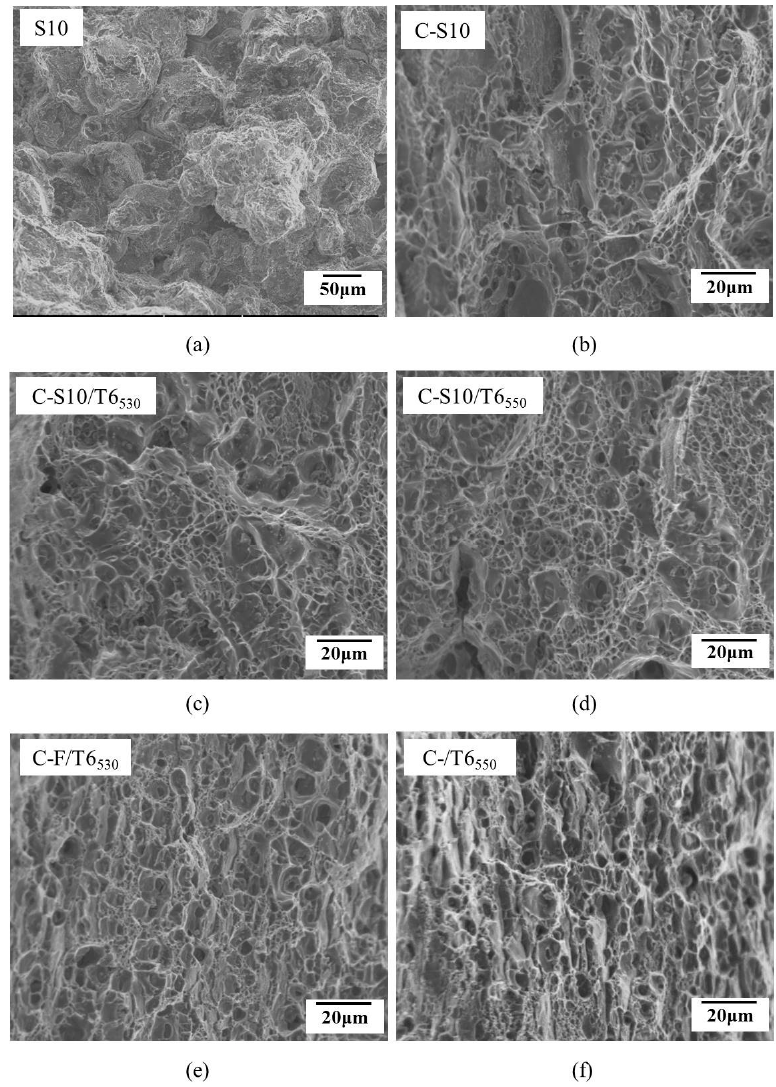
Figure 14. Fracture surfaces of ( a ) S10; ( b ) C ‐ S10; ( c ) C ‐ S10/T6 530 ; ( d ) C ‐ S10/T6 550 ; ( e ) C ‐ F/T6 530 ; and ( f ) C ‐ F/T6 550 .